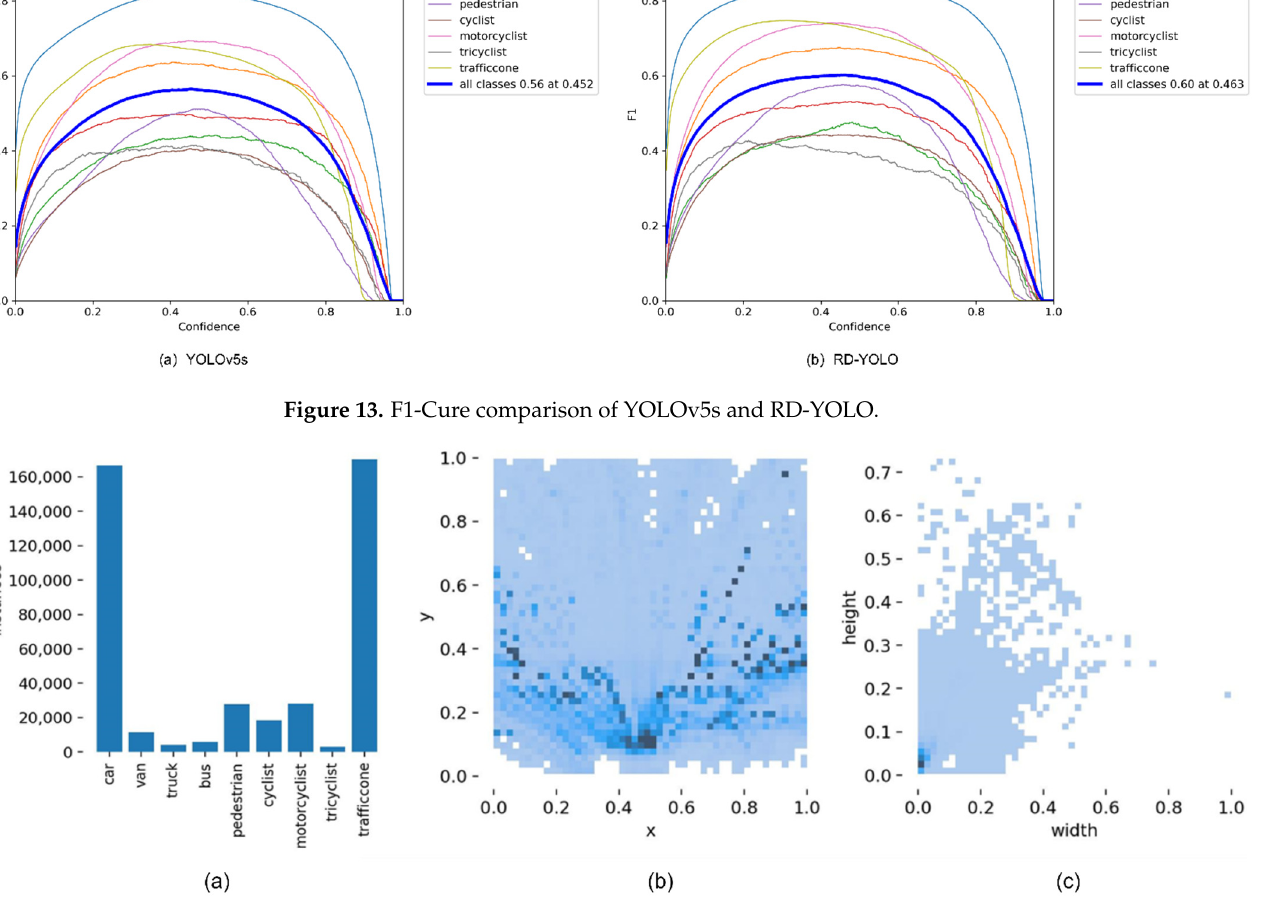
Figure 14. The visualization result of the analysis of the Rope3D dataset. ( a ) The distribution of detection object category and label. ( b ) The distribution of detection object center locations. ( c ) The distribution of detection object sizes.